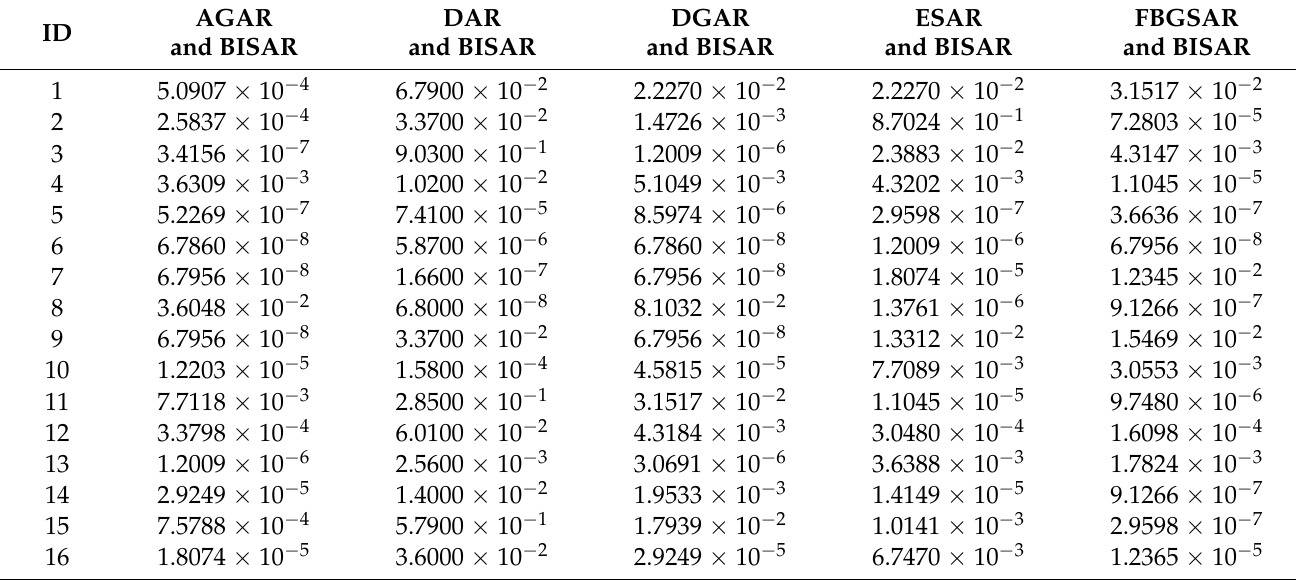
Table 7. p -values for comparing stabilities (feature